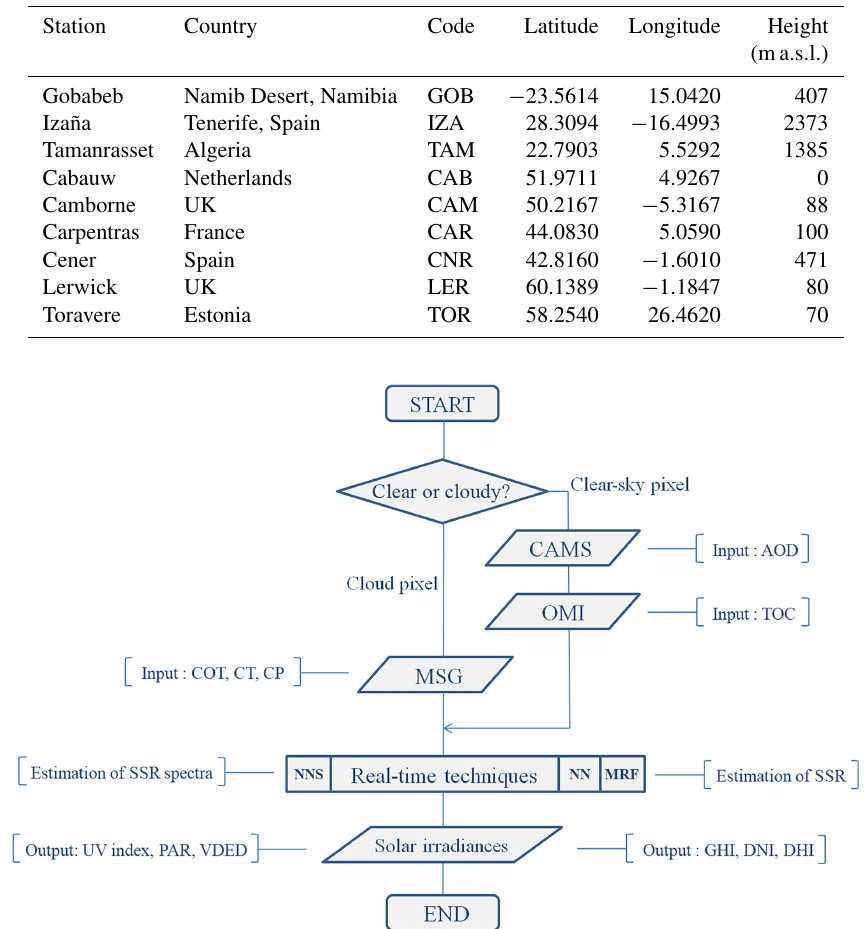
Table 1. Coordinates (degrees) and height (metres above sea level) of the BSRN stations used for the validation.